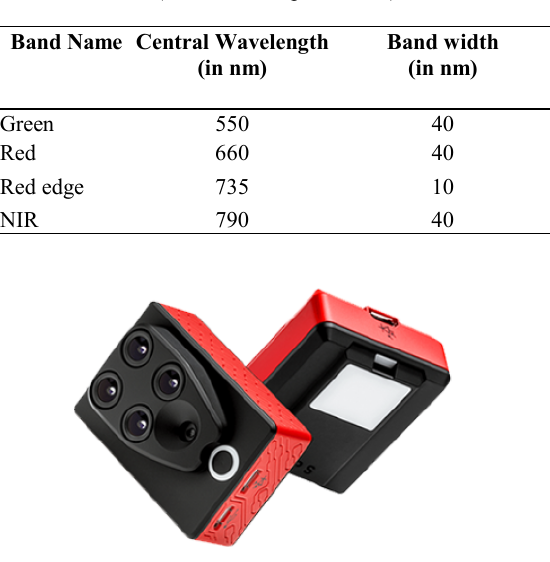
Figure 3. Parrot Sequoia sensor and sunshine